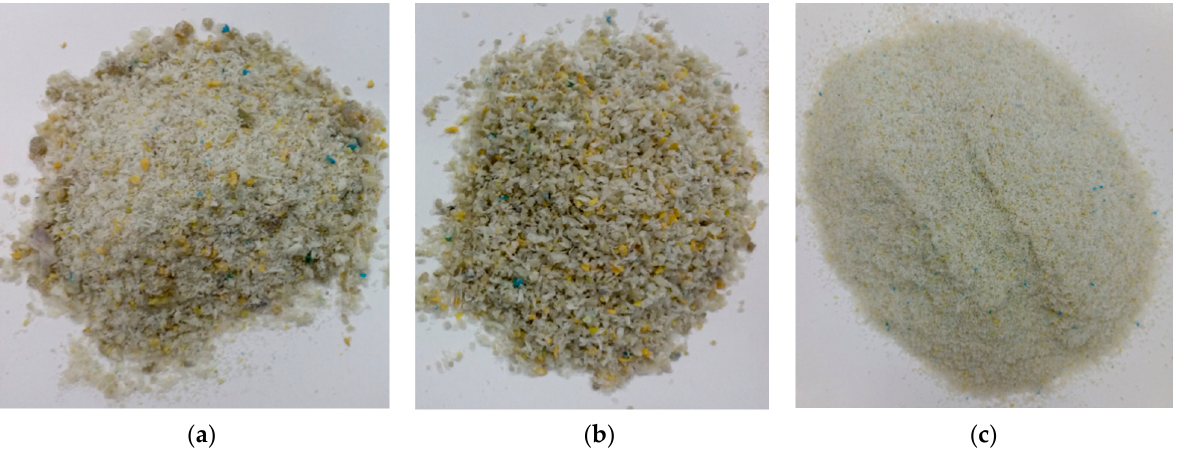
Figure 3. PE agglomerate: ( a ) before the selection into fractions, ( b ) 1 mm fraction, ( c ) 0.25 mm fraction.